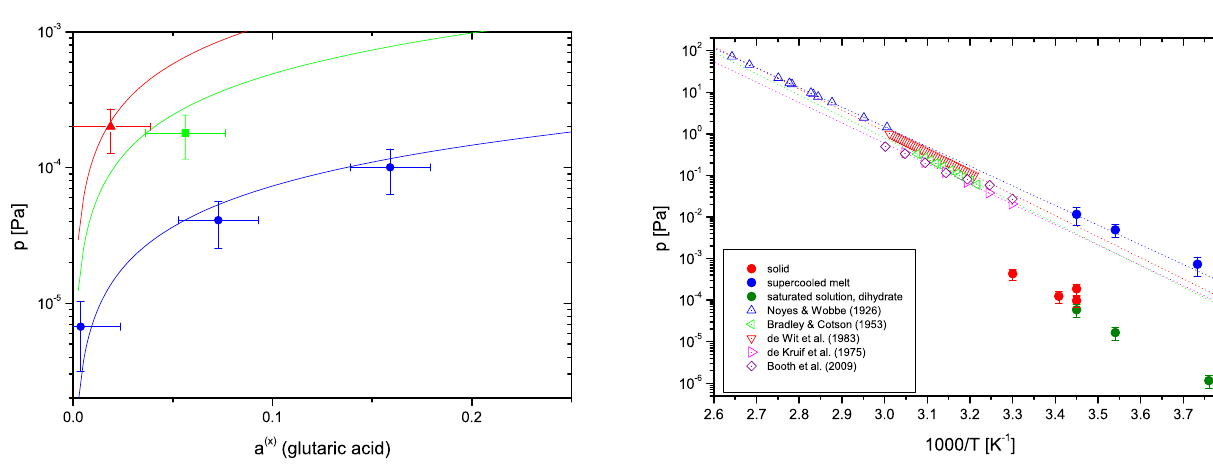
Fig. 11. Vapor pressure of oxalic acid plotted versus activity from UNIFAC-Peng (Peng et al., 2001). Data at T = 267 . 3K: , T = 282 . 4K: (cid:4) , T = 289 . 9K: N . Lines are the results of one fit to all data with Eq. (3).